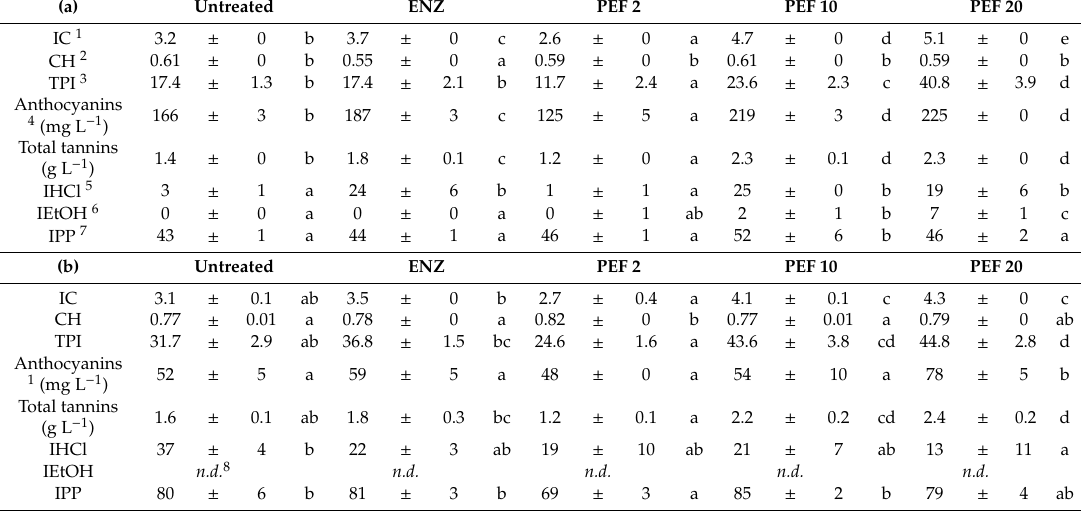
Table 3. Values (means ± SD) of the parameters characterizing the polyphenolic fraction of the wines, analyzed after two ( a ) and twelve months ( b ) of bottle storage. Di ff erent letters mark significant di ff erences according to ANOVA and Tukey HSD test ( p < 0.05). Refer to Table 1 for sample